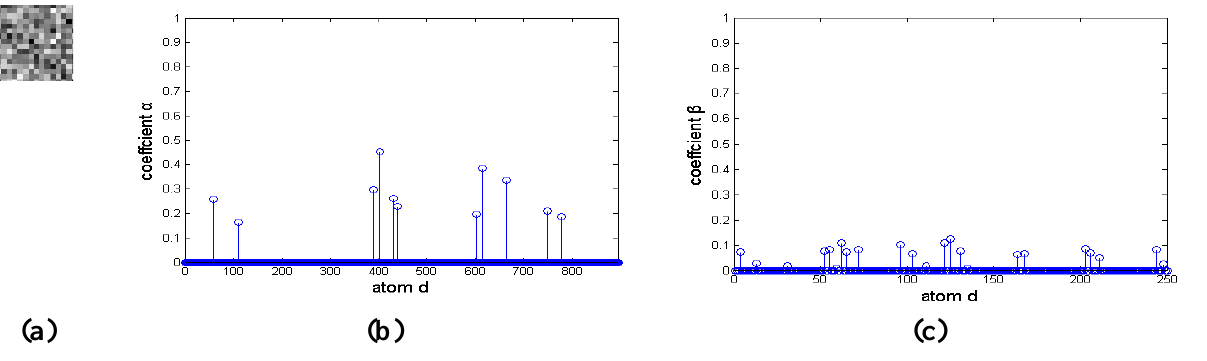
Figure 14. Representation coefficient of background block in deep space image decomposed on discriminative over-complete dictionary. ( a ) Sparse coefficient on background dictionary, ( b ) Sparse coefficient on target dictionary.